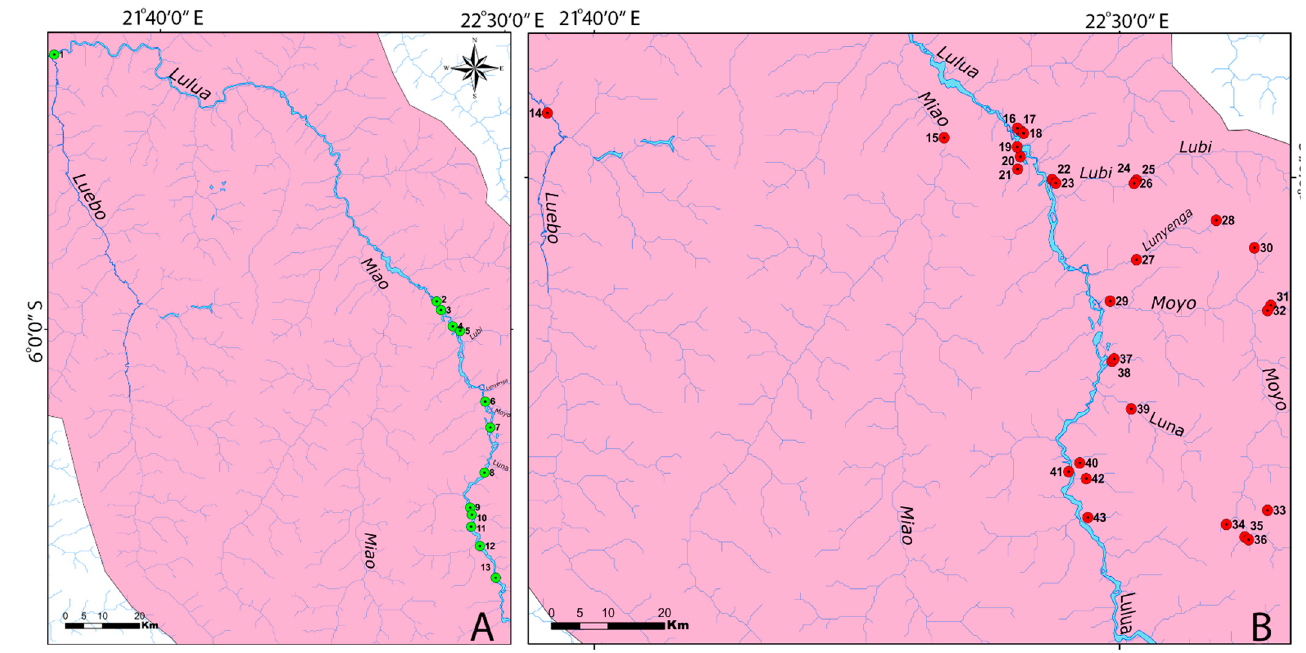
Figure 3. Map of the LR sampling sites: ( A ) green circles, main channel sites; ( B ) red circles, tributary and sub-tributary sites.